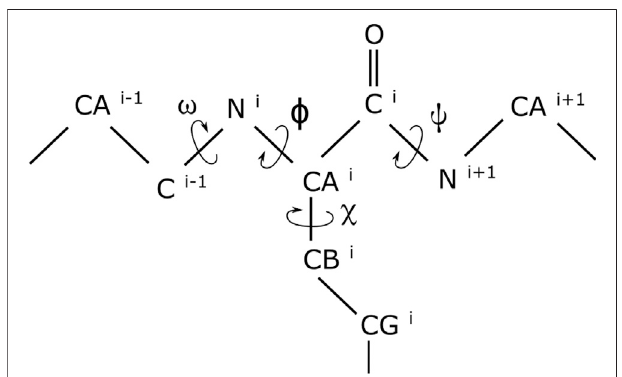
FIGURE 1 | Dihedral angles in a short segment of a protein. While the omega( ω ),phi( ϕ ),andpsi( ψ )dihedralanglesareintheproteinsbackbone,the chi 1 ( χ 1) dihedral angle is at the beginning of an amino acid ’ s side